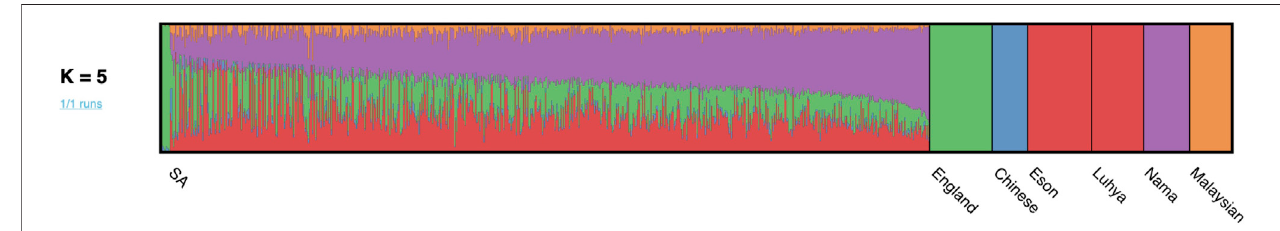
FIGURE 1 | Genome-wide ancestral proportions of all SA individuals, with the ancestry proportion of each individual plotted vertically.